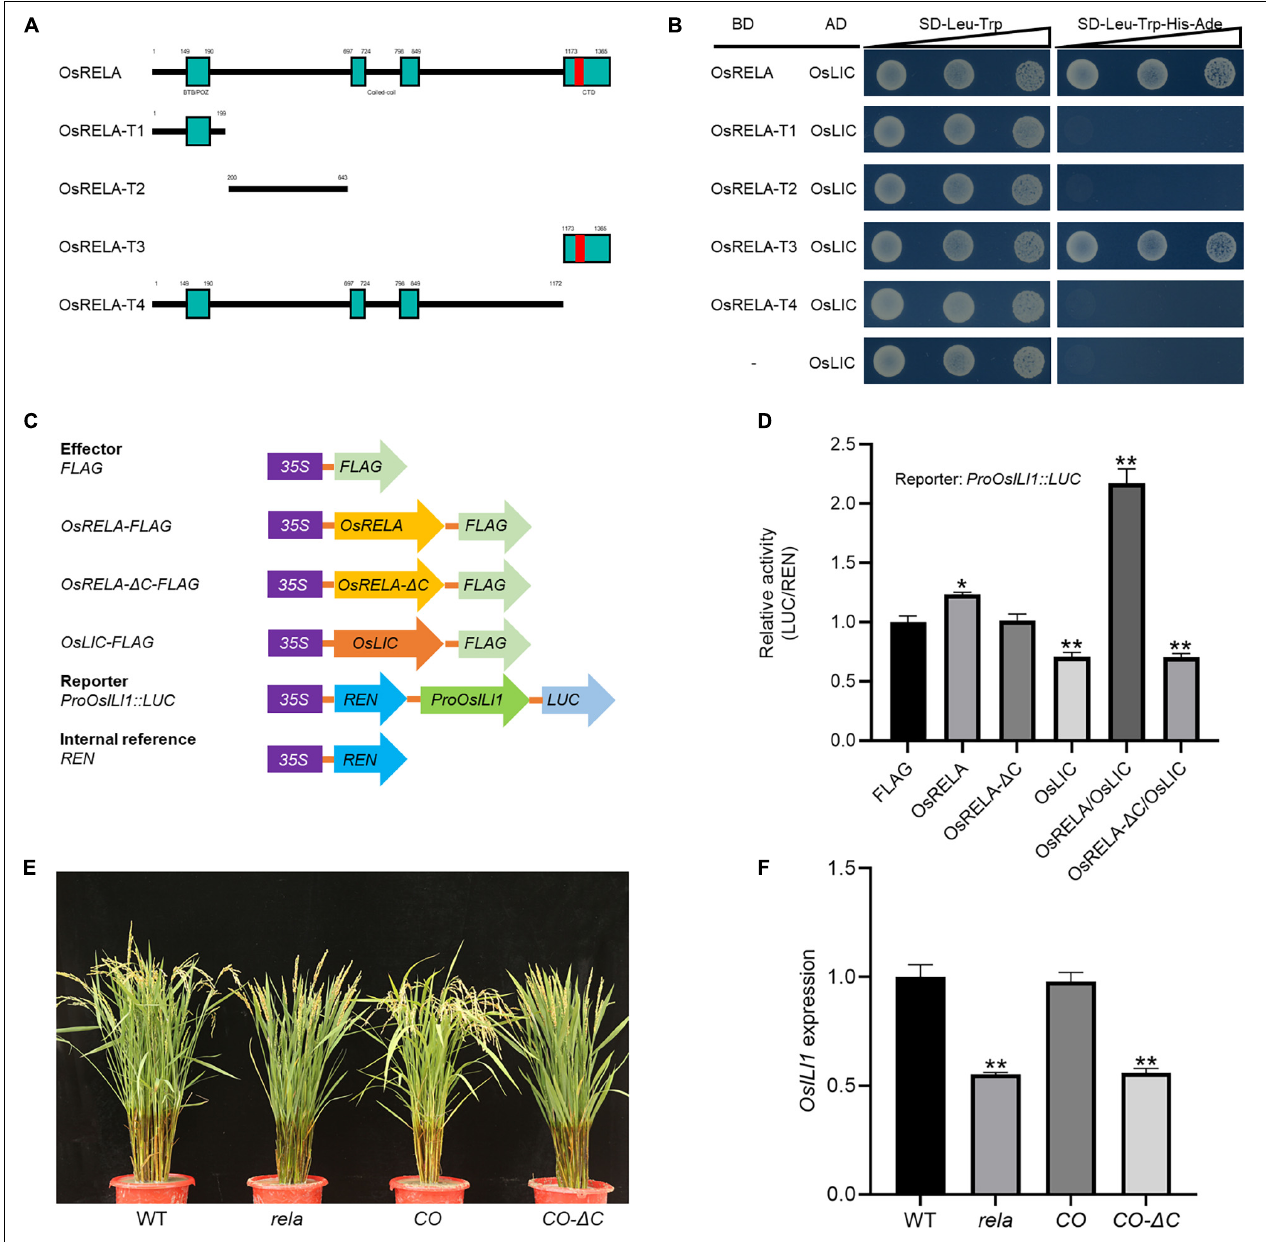
FIGURE 6 | The OsRELA-OsLIC interaction occurs via the conserved C-terminal of OsRELA. (A) Schematic representation of wild-type and different truncated forms of OsRELA. (B) Yeast two-hybrid assays show that OsLIC interacts with OsRELA and OsRELA-T3. AD, activation domain; BD, binding domain; SD, synthetic dropout; the gradients indicate tenfold serial dilutions. (C) Schematic diagrams of the reporter and effector constructs. The firefly luciferase ( LUC ) gene driven by the OsILI1 promoter and the Renilla luciferase ( REN ) reporter gene driven by the 35S promoter were used as the reporter and internal control, respectively. For the effectors, OsRELA, OsRELA (cid:49) C and OsLIC were fused with FLAG . (D) Transient gene expression assays in rice protoplasts. The LUC reporter gene was cotransfected with OsRELA, OsRELA (cid:49) C and OsLIC or both. Asterisks indicate significant differences from the control (* P < 0.05, ** P < 0.01, Student’s t -test). (E) Plant morphologies of wild-type, rela, rela/proOsRELA:OsRELA ( CO ) and rela/proOsRELA:OsRELA (cid:49) C ( CO– (cid:49) C ) at the heading stage. Bar = 10 cm. (F) RT–qPCR analysis of OsILI1 expression levels in wild-type, rela, rela/proOsRELA:OsRELA ( CO ) and rela/proOsRELA:OsRELA (cid:49) C ( CO– (cid:49) C ) lamina joints. The rice UBQ gene was amplified as the internal control. Asterisks indicate significant differences from the WT (** P < 0.01, Student’s t -test).